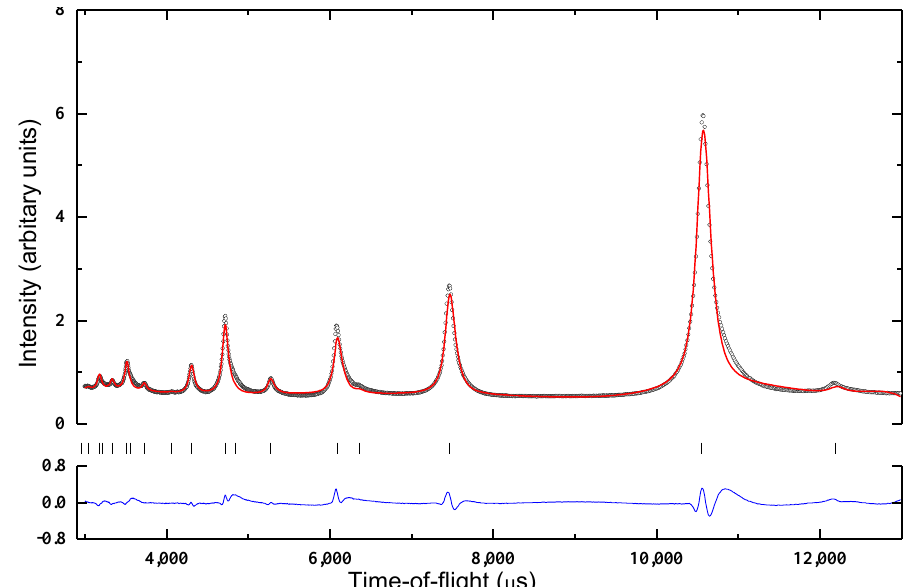
Figure 4. Rietveld refinement of Ti 0.63 V 0.27 Fe 0.10 D 1.73 with the Bragg peaks in the neutron total scattering data from the GEM diffractometer, ISIS. Open circles — experimental data, red solid line — calculated data, below — difference plot. Bragg peak positions for the FCC structure model are marked with vertical tick marks.